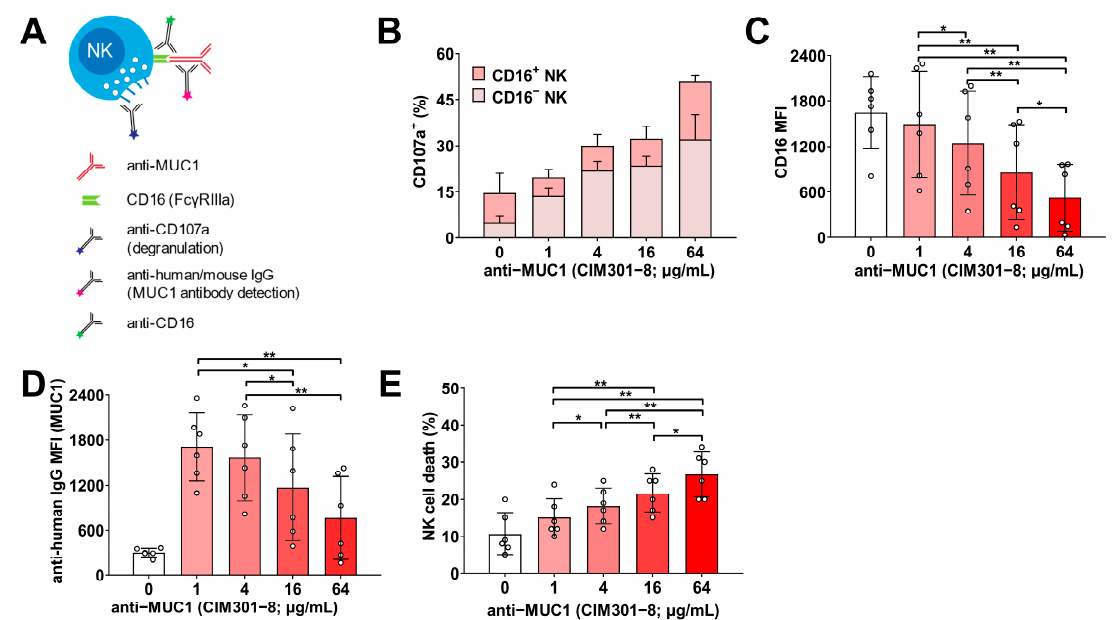
Figure 3. Increasing concentrations of humanized anti-MUC1 antibodies enhance degranulation and induce down-regulation of CD16 expression on NK cells. ( A ) Experimental setup for the detection of anti-MUC1 antibody binding to NK cells, inducing degranulation and down-modulation of CD16 on NK cells. Human NK cells were incubated with increasing concentrations of anti-MUC1 (CIM301-8; defucosylated Fc-tail). Antibody binding to CD16 was analyzed using flow cytometric analysis of anti-human IgG antibodies. ( B ) Stacked bars show the fraction of NK cell degranulation for CD16 + and CD16 − NK populations in the presence of various antibody concentrations. ( C ) Quantification of CD16 expression on NK cells. ( D ) Quantification of anti-MUC1 antibody binding to the Fc tail of NK cells, shown as median fluorescence index (MFI) of anti-human IgG. ( E ) Quantification of NK cell death after 4 h incubation with increasing doses of anti-MUC1 antibody. Bars indicate mean ± SD, and dots are individual NK cell donors ( n = 6 per experimental group). Statistical analysis using one-way ANOVA plus Tukey’s multiple comparisons test. p < 0.05 (*); p < 0.01 (**).